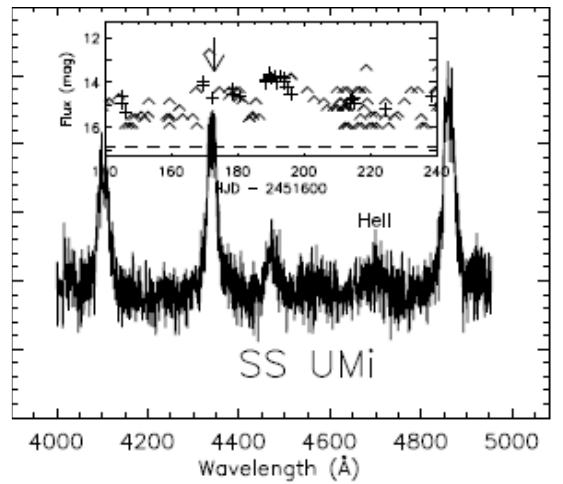
Fig.2: SS UMI spectroscopic light curve